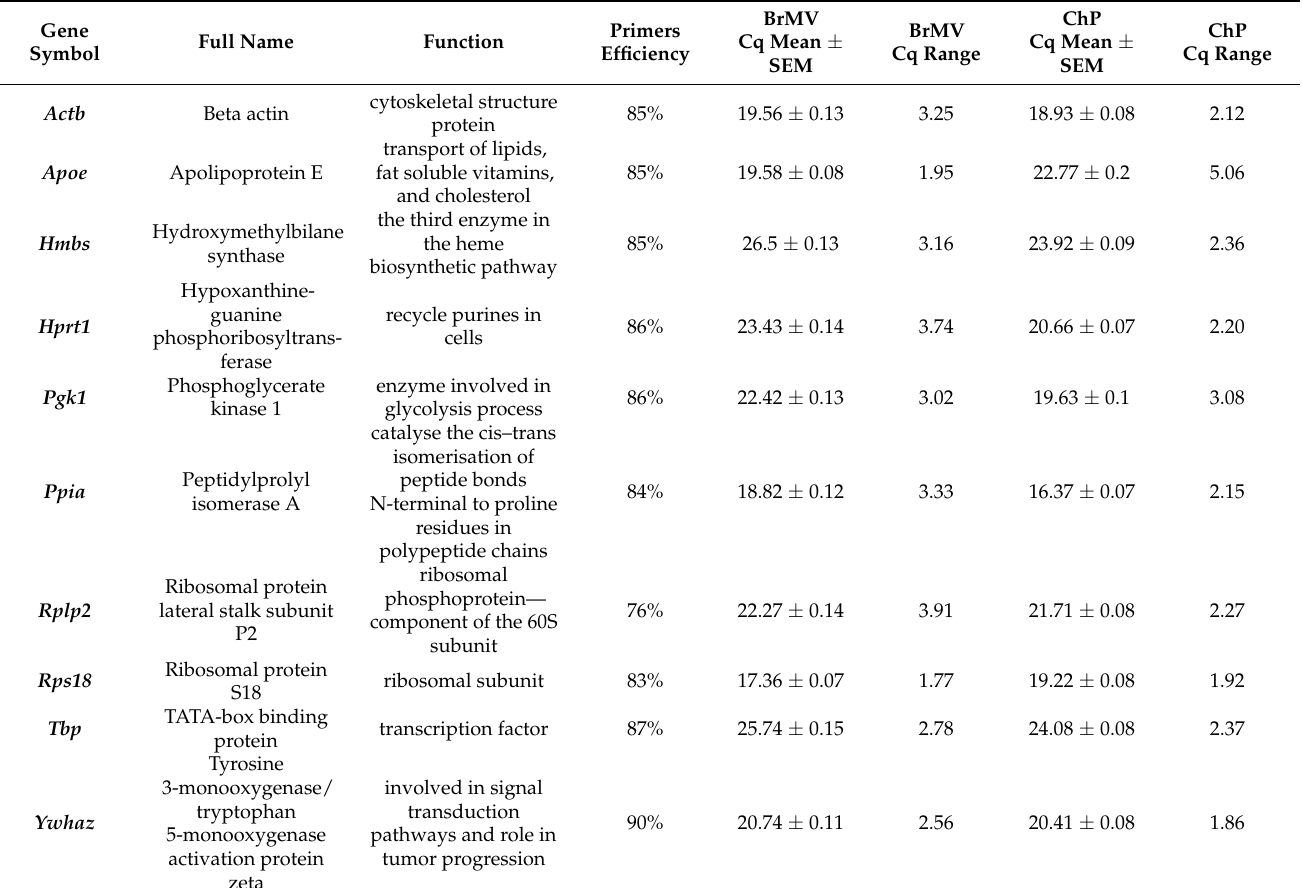
Table 2. Reference genes analyzed in brain cortical microvessel and choroid plexus samples: gene names, functions, the efficiency of qPCR reaction, and raw quantification cycle